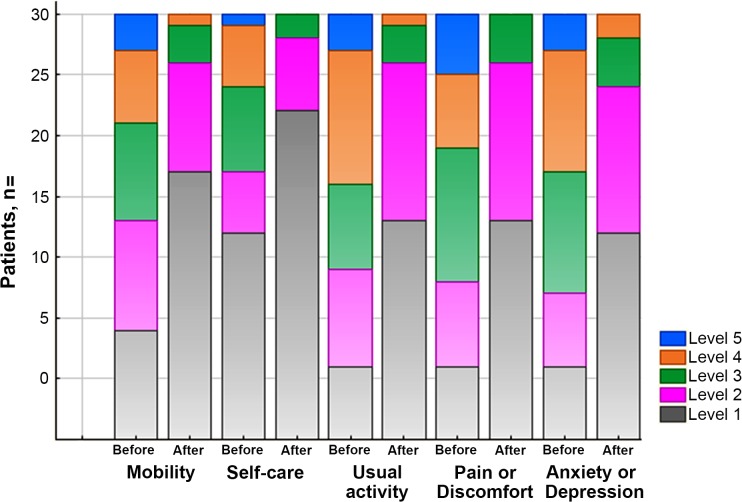
Illustration of HRQoL assessment by reported levels 1 to 5 for each dimension of the EQ-5D-5L instrument.Patients reported less problems after restoring of euthyroidism as compared to hyperthyroid state.